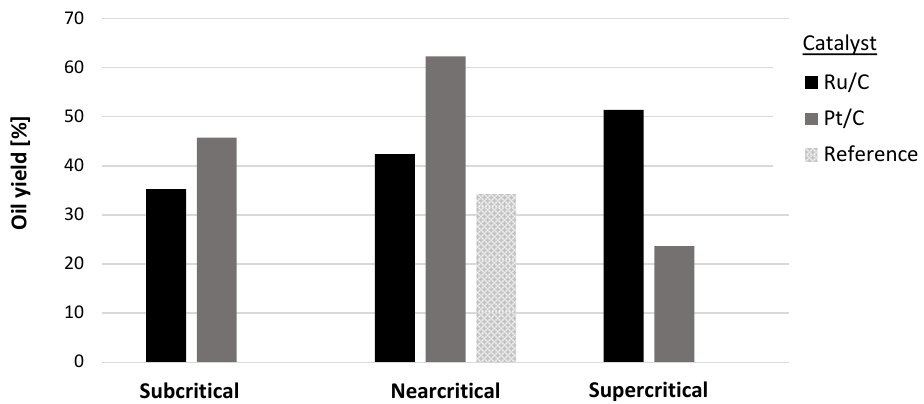
Figure 2. Yield in lignin oil obtained by catalytic hydrogenolysis of kraft lignin in methanol at subcritical (200 ◦ C, 76 bar, left ), near-critical (235 ◦ C, 110 bar, middle ), and supercritical (250 ◦ C, 131 bar, right ) conditions.